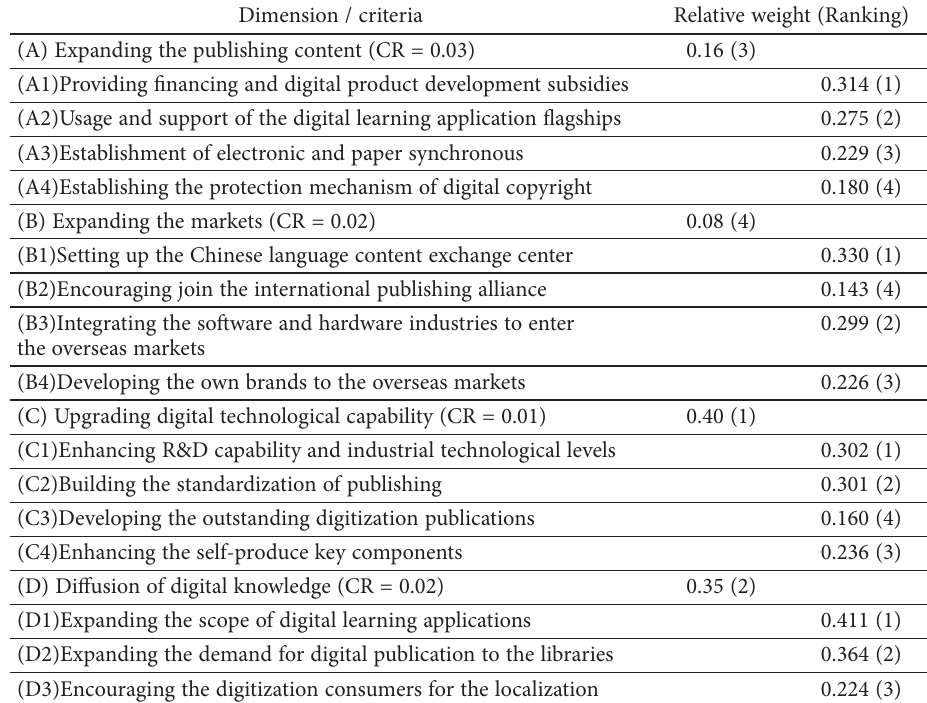
Table 6. Priorities and weights of critical success factors Dimension / criteria Relative weight